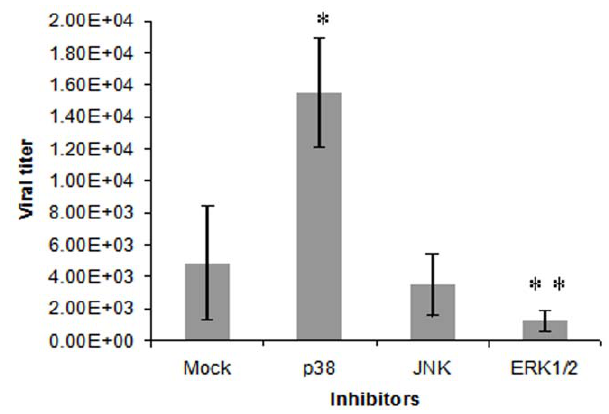
Figure 7. Effect of inhibitors on RVFV replication. HSAECS were plated at 5 6 10 4 cells per well in a 96-well plate and pretreated with either DMSO or indicated inhibitors for 5 h prior to RVFV infection at MOI of 0.002 as described in Materials and Methods. Following infection, fresh medium containing inhibitors was added. Supernatants were collected at 48 h.p.i., viral RNA extracted and analyzed by